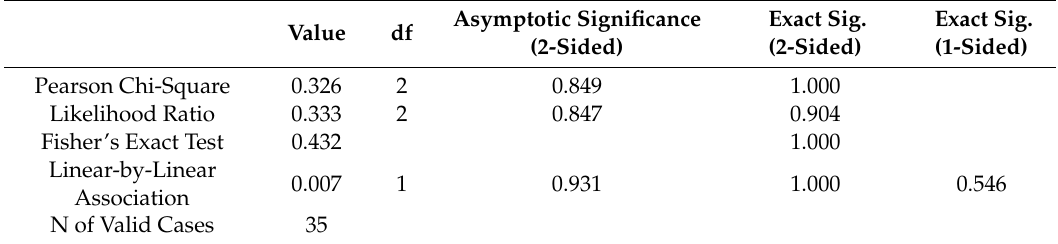
Table 3. The chi-square test for designing problems.